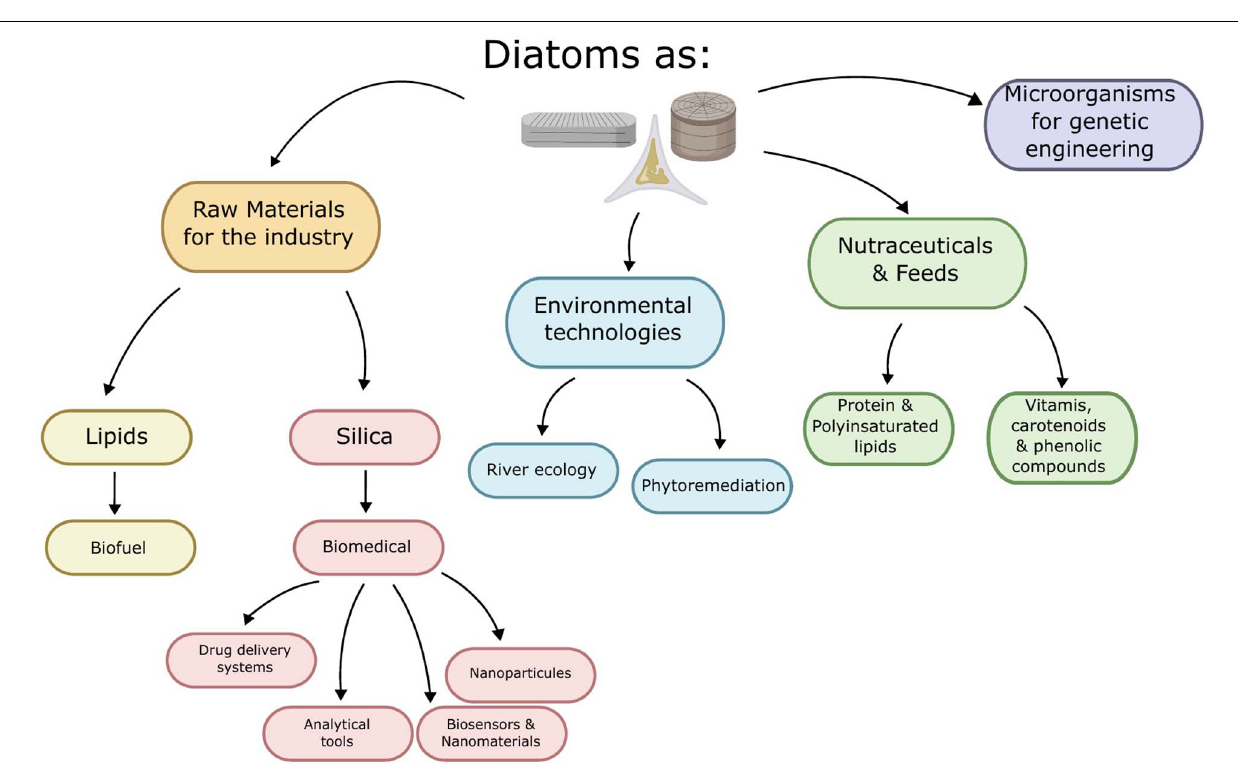
FIGURE 2 | Scheme of the different uses of diatoms for green